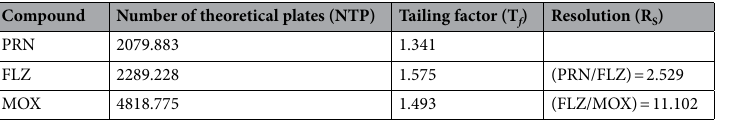
Table 1. The optimum chromatographic parameters obtained for separation of the studied drugs by the proposed HILIC method.